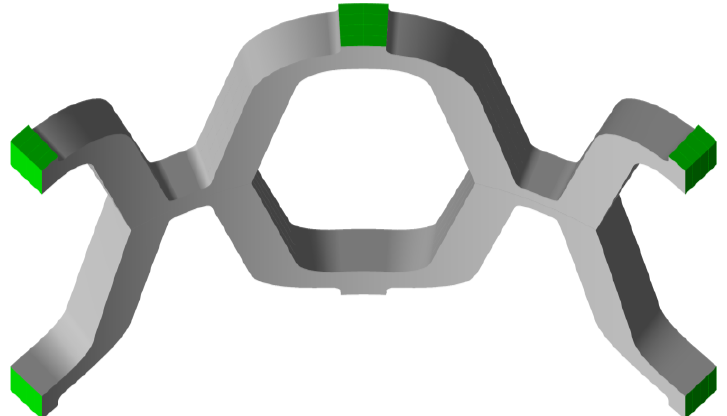
Figure 4. Boundary condition surfaces on the stent (green).